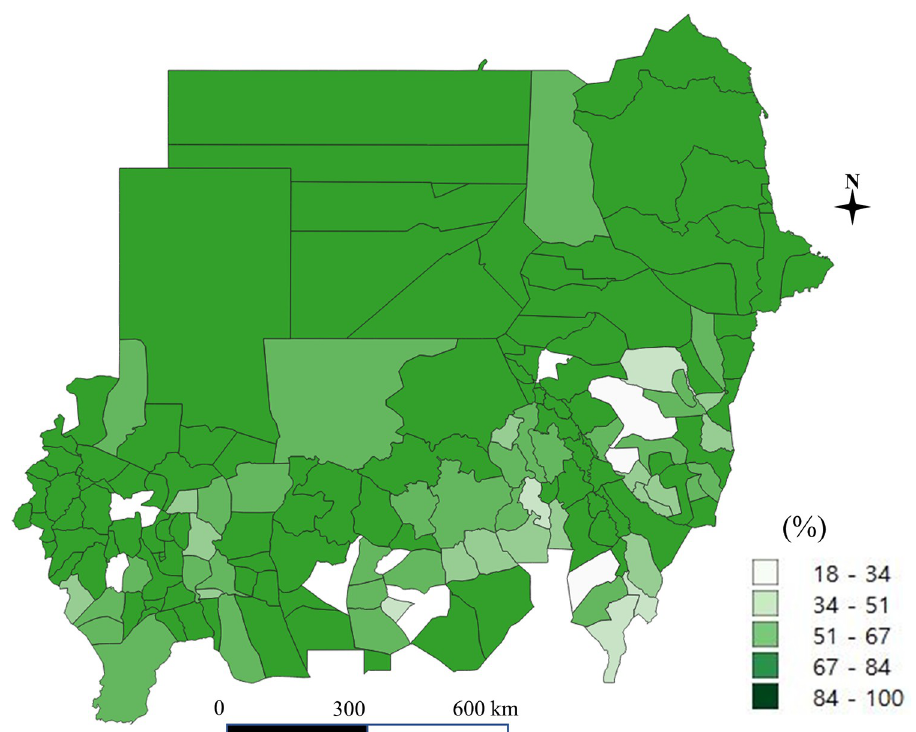
Fig 2. Improved water at the household level (the authors generated the map). https://doi.org/10.1371/journal.pone.0258418.g002 PLOS ONE | https://doi.org/10.1371/journal.pone.0258418 October 15,